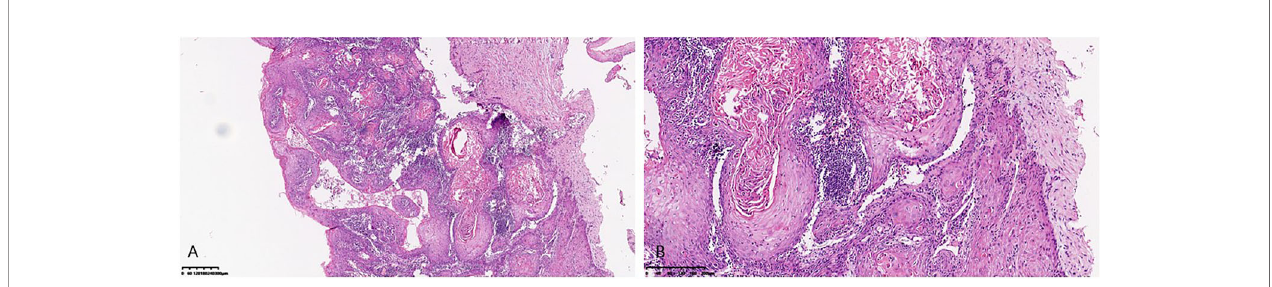
FIGURE 1 | Microscopic pattern of verrucous carcinoma of the vulva. (A) Low-power view of verrucous carcinoma of the vulva showing nests and islands of well- differentiated squamous epithelial cells embedded in a dense stroma. (B) High-power view showing extremely well- differentiated squamous epithelial